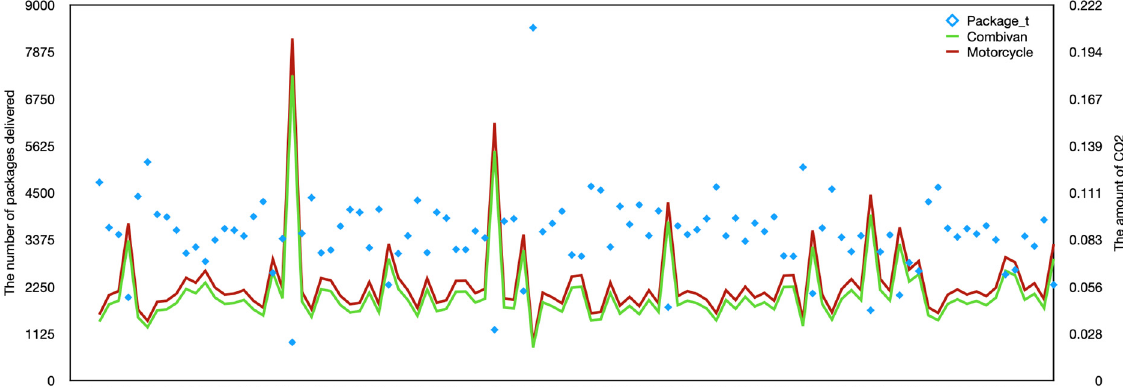
Figure 6. CO 2 emission values of motorcycle and combivan distribution vehicles depending on the package density distributed.